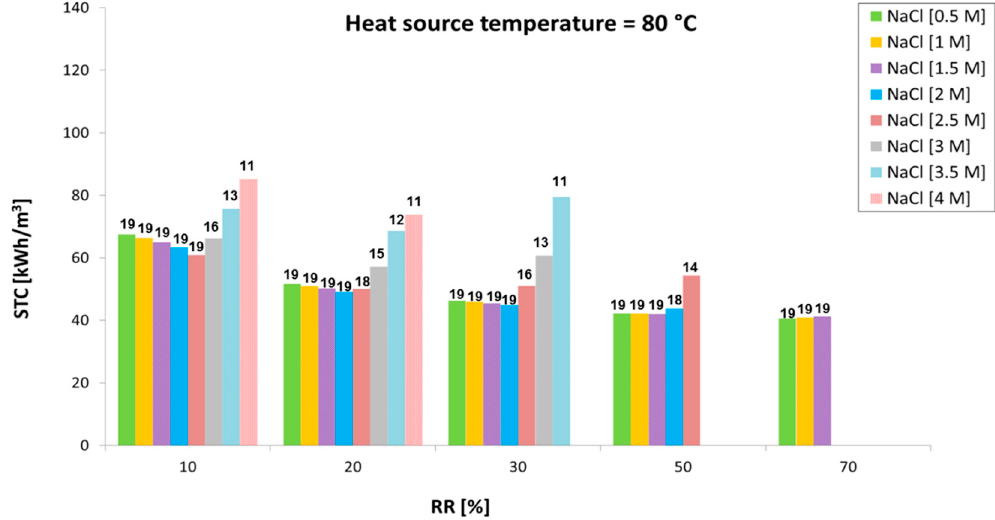
Figure 11. Variation of the specific thermal consumption with the recovery ratio at different inlet concentrations with a heat source at 80 °C.